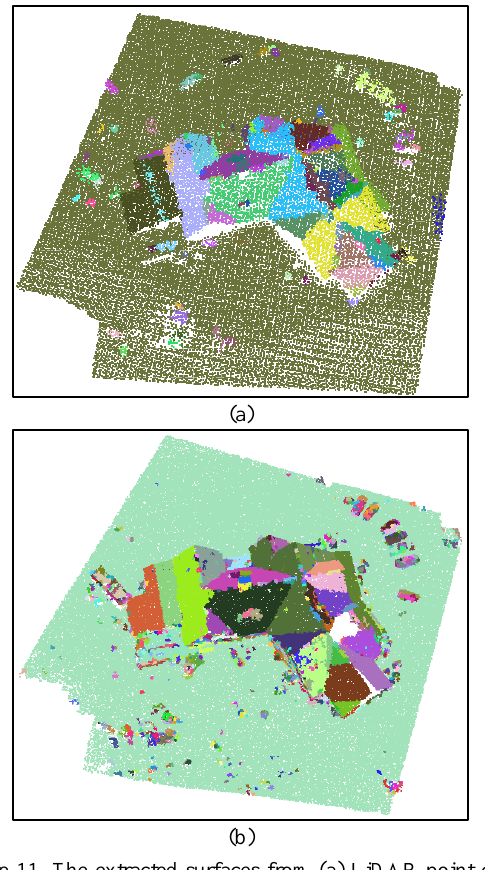
Figure 11. The extracted surfaces from (a) LiDAR point cloud and (b) imagery-based point cloud